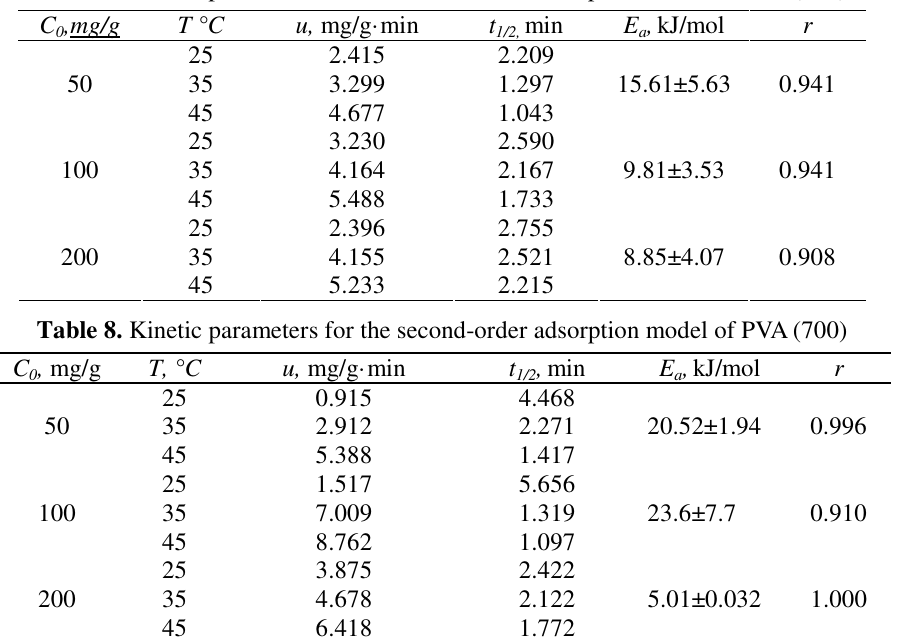
Table 7. Kinetic parameters for the second-order adsorption model of PVA (500)